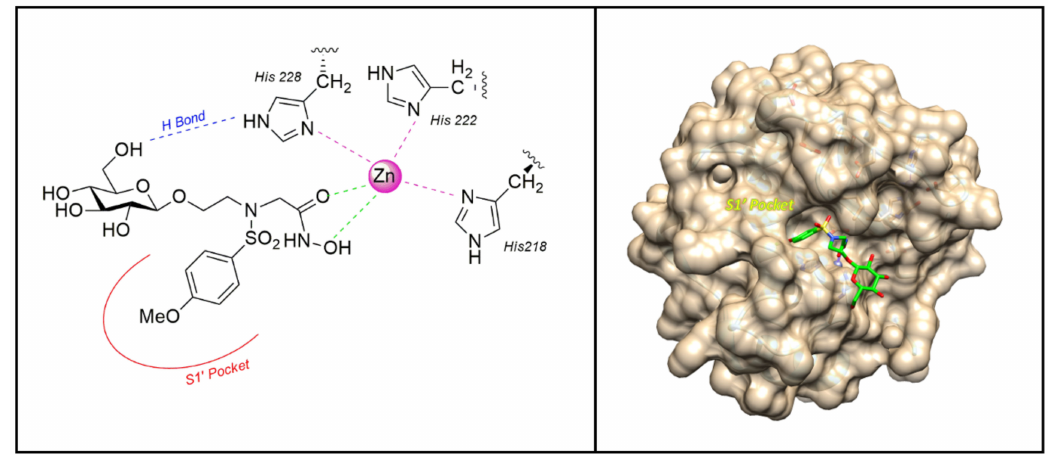
Figure 6. The binding mode of 3 [73] in the MMP-12 catalytic domain (PDB: 3N2U). Image generated with Chimera, version